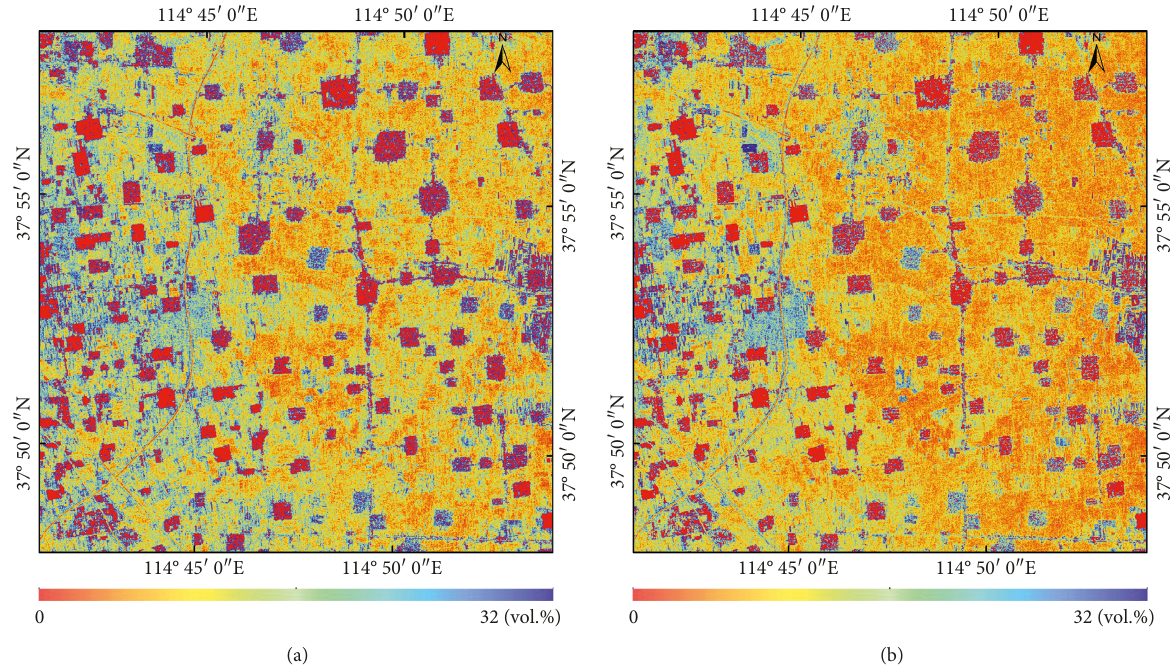
Figure 8: Soil moisture retrieval results of (a) HH and (b) VV polarizations using GF-3